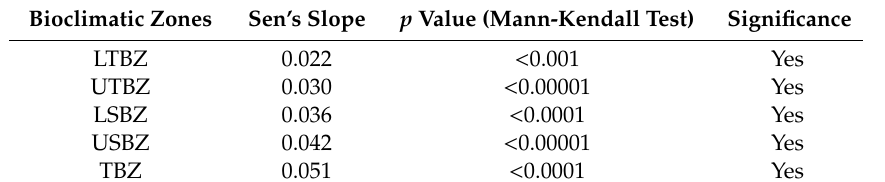
Table 3. Average temperature trend (1970–2019) in di ff erent bioclimatic zones in CHAL. Bioclimatic Zones